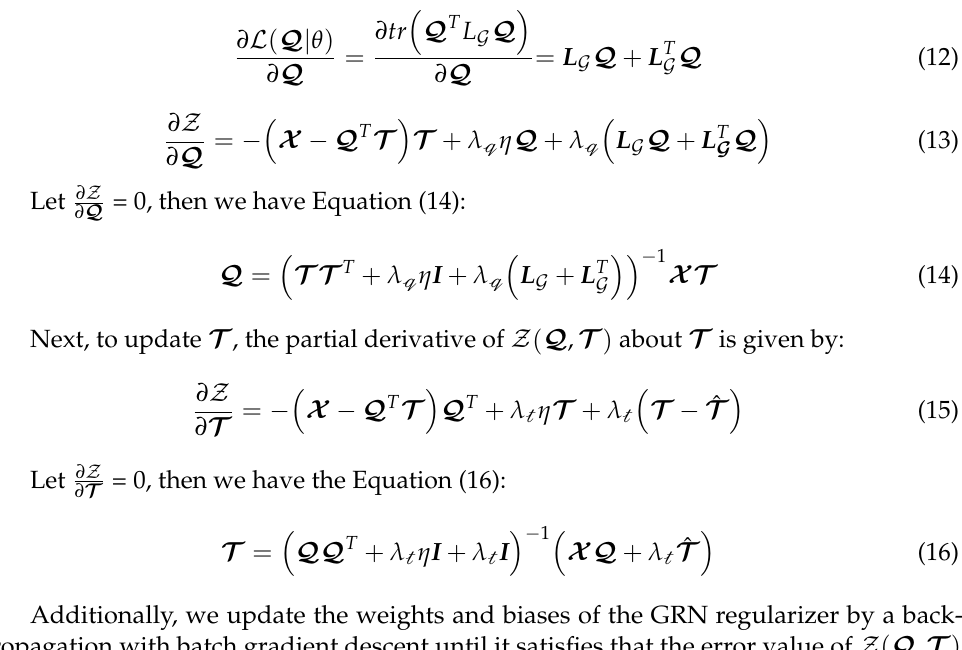
Figure 1. Illustration of multivariate time series forecasting (each 𝔁 (cid:3047) is a frame of traffic data at time step 𝑡 ).